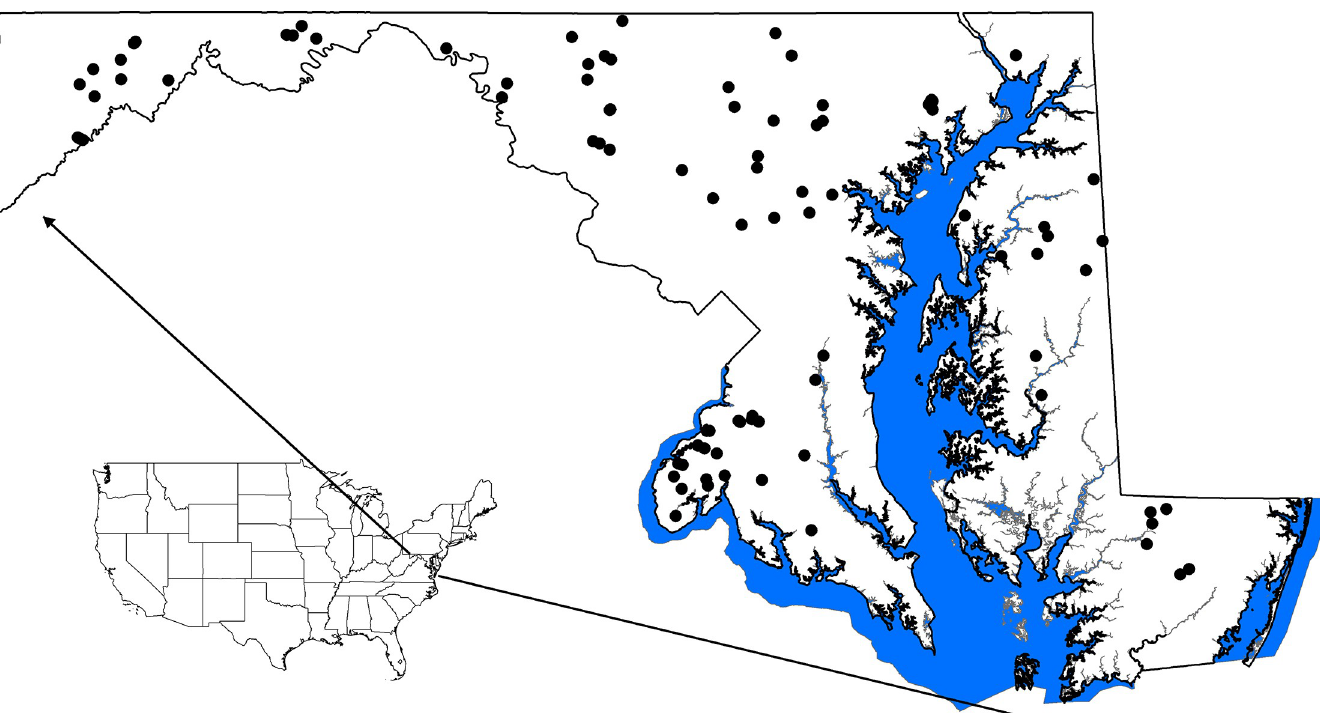
Fig 1. Map of the study area. We collected water column and sediment microbial samples in both spring and summer in 82 streams across the state of Maryland, USA. Nation and state outline source: US Census Bureau 2018 TIGER/Line Shapefile. Coastal boundary source: Maryland Geological Survey.